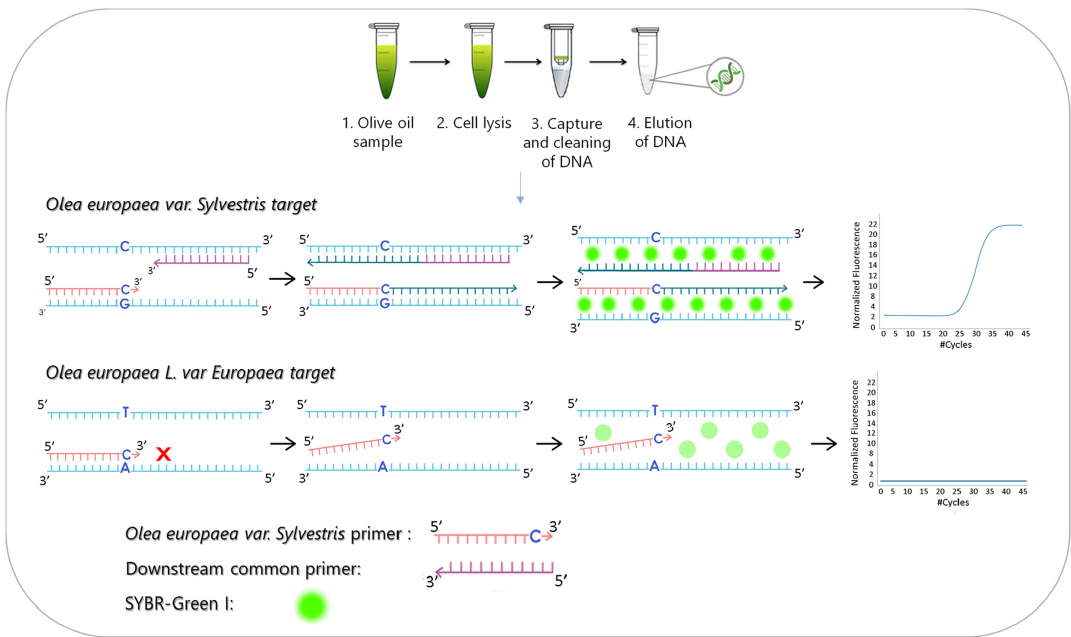
Figure 1. ( Upper panel ) Schematic illustration of the principle of the method that includes DNA isolation and purification from olive oil samples using spin cleanup columns, including the following steps: cell lysis of an olive oil sample, capture of DNA to the cleanup columns and elution of the DNA from the columns. ( Lower panel ) The allele-specific, real-time PCR. Two allele-specific upstream primers that contain the SNP of interest at their 3 ΄ ends and one common downstream primer were used in the amplification reaction. Only the perfectly complementary upstream primer to the target was extended by the DNA polymerase, while the amplicons were detected by the DNA intercalating dye, SYBR Green I.